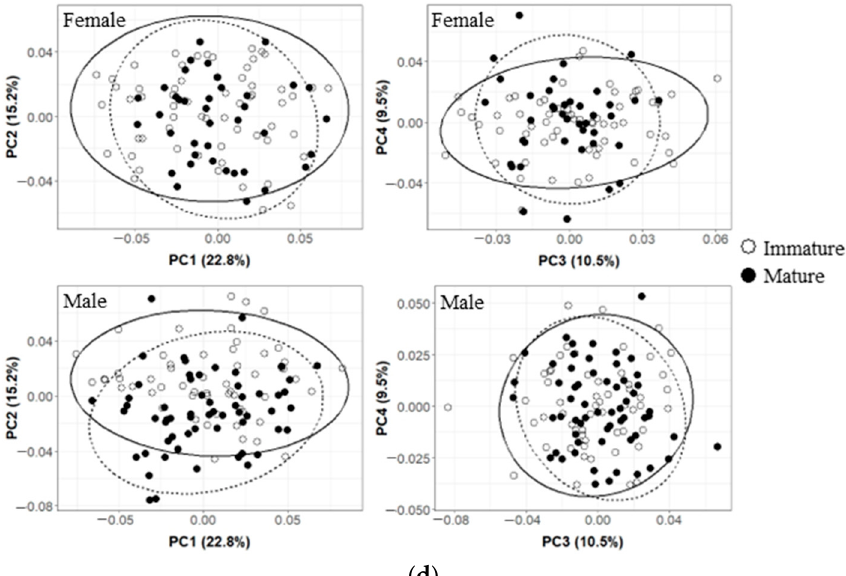
Figure 6. Results of principal component analysis (PCA) of lower beak of the four cephalopods, showing the first principal component (PC1) versus (PC2) and (PC3) versus (PC4) shape variation with 95% ellipse confidence intervals of immature (solid line) and mature (dashed line). ( a ) Octopus minor . ( b ) Uroteuthis edulis . ( c ) Sepia esculenta . ( d ) Sthenoteuthis oualaniensis .